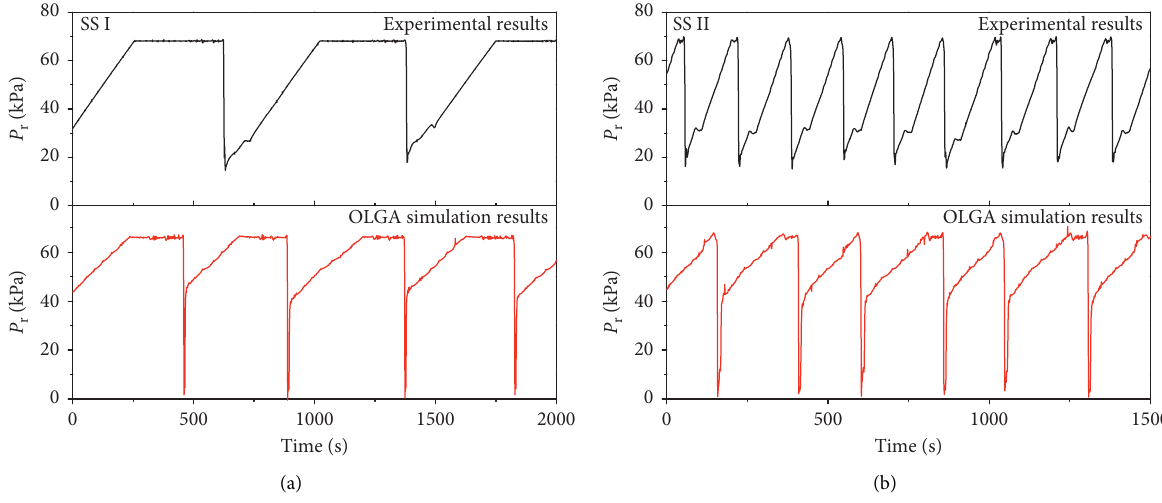
r in pipeline systems with or without hilly-terrain unit. (a) � 0.239m/s, v � 1.356m/s. (d) v sl sg